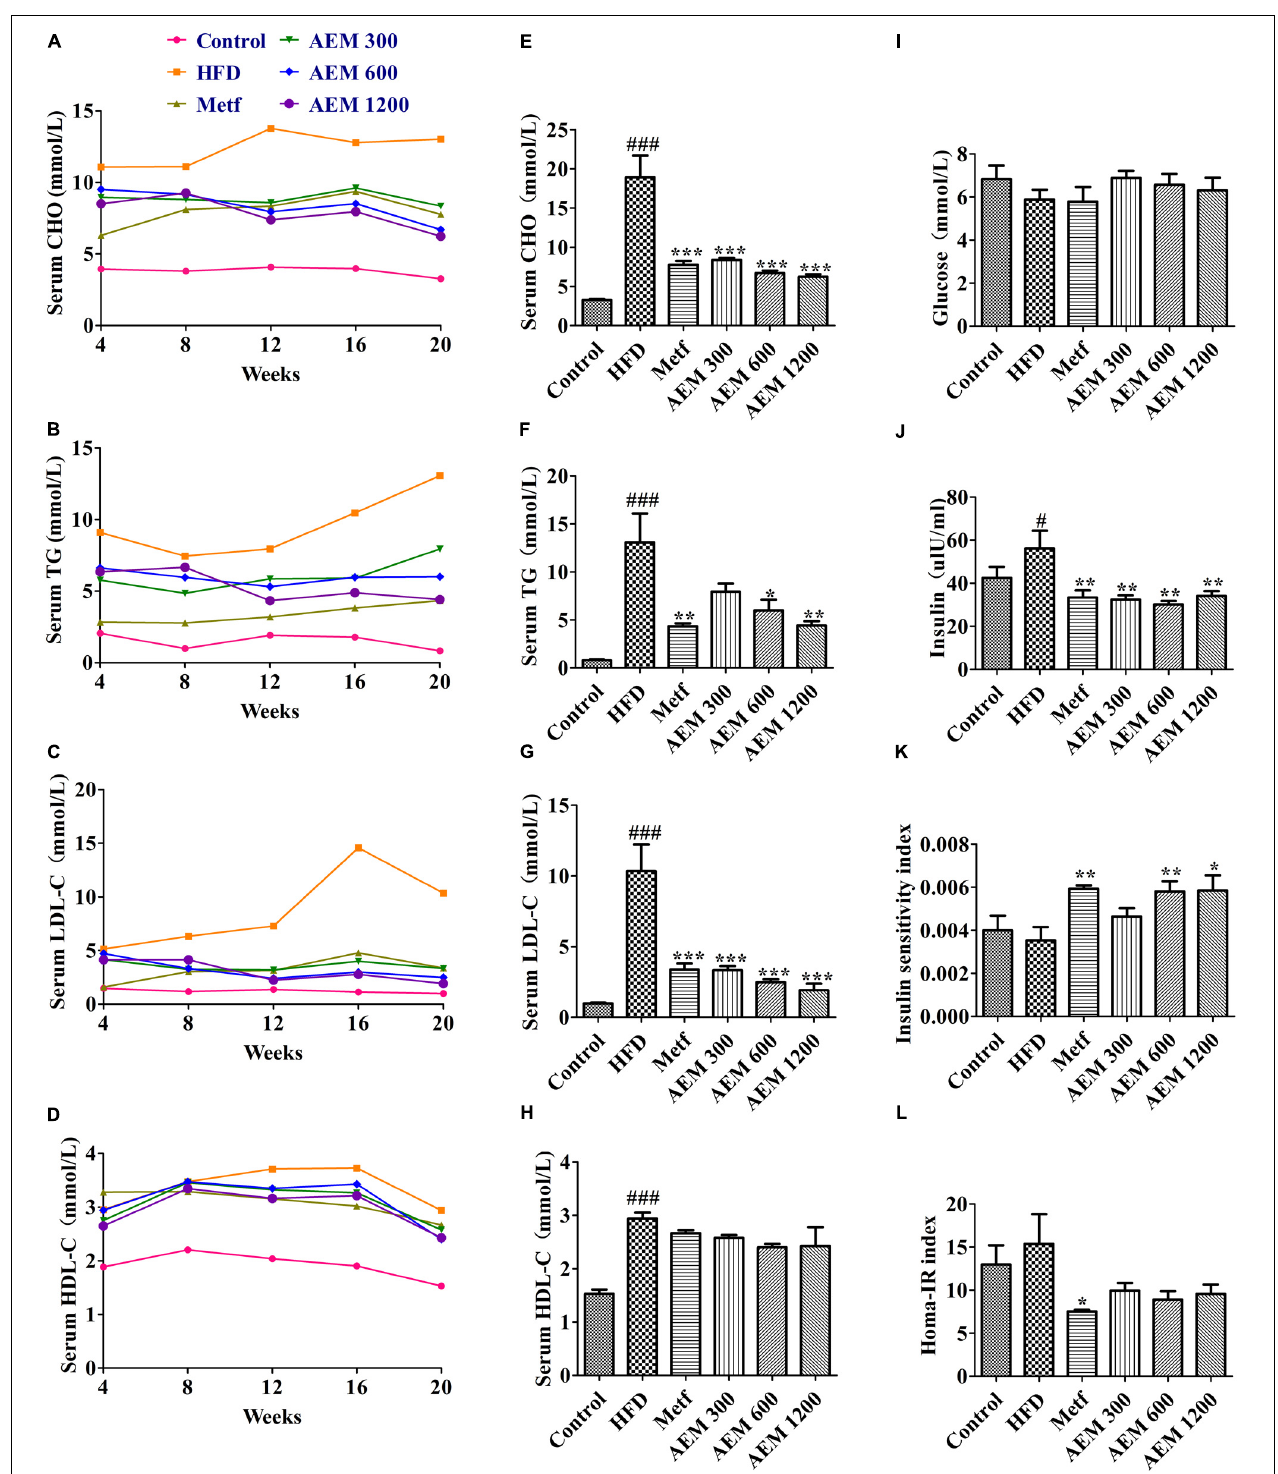
FIGURE 2 | Effects of aqueous extract of black maca (AEM) on the serum lipid, glucose, and insulin profiles in golden hamsters. Over 20 weeks, (A) serum cholesterol (CHO), (B) serum triglyceride (TG), (C) serum low-density lipoprotein CHO (LDL-C), and (D) high-density lipoprotein CHO (HDL-C) levels were tested. At the end of 20 weeks, (E) serum CHO, (F) serum TG, (G) serum LDL-C, (H) serum HDL-C, (I) serum glucose, and (J) serum insulin were measured. The calculated insulin sensitivity index (K) and HOMA-IR index (L) are displayed. Data are presented as the means ± SEMs. # P < 0.05, ## P < 0.01, ### P < 0.001 compared with the control group; ∗ P < 0.05, ∗∗ P < 0.01, ∗∗∗ P < 0.001 compared with the HFD model group, n = 6.